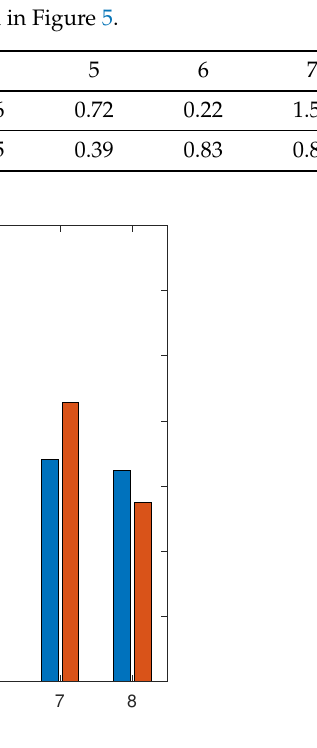
Figure 5. Allocated power versus index of subcarriers when transmit power per node is 20 dBm; N =